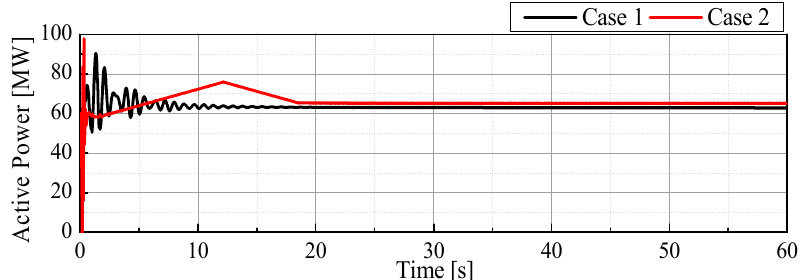
Figure 14. System frequency (Generating Operation).